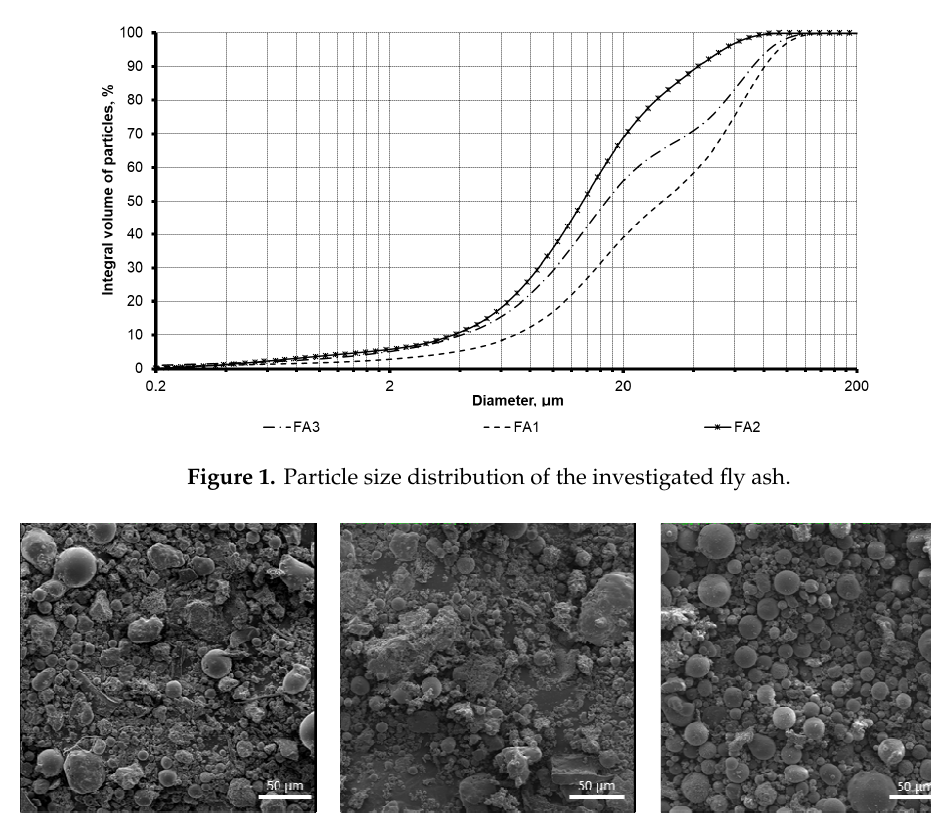
Figure 2. Micrographs of the fly ash products. ( a ) FA1; ( b ) FA2; ( c ) FA3.